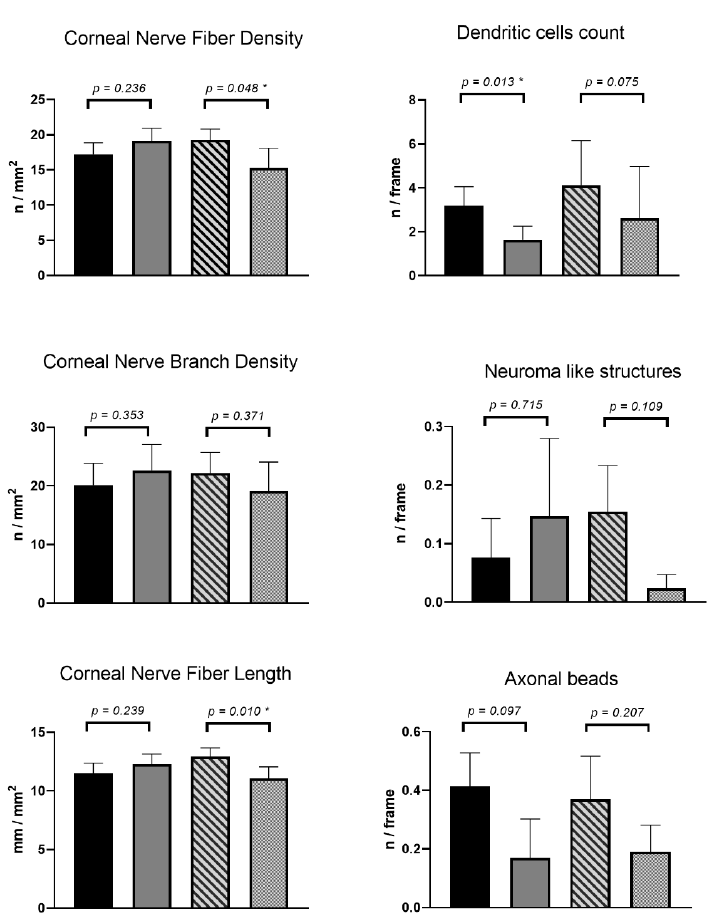
Figure 2. Corneal nerve quantification and morphological alterations Evaporative Dry Eye subtypes according to groups of treatment. Asterisks (*) in the graphs indicate statistical differences between groups (p<0.05).